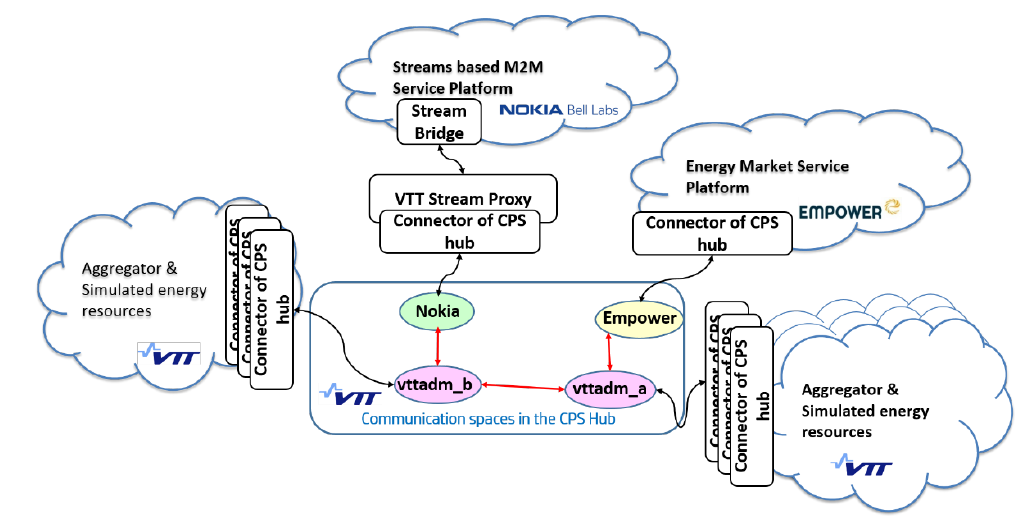
Figure 26. The CPS hub with streams based M2M service platform.